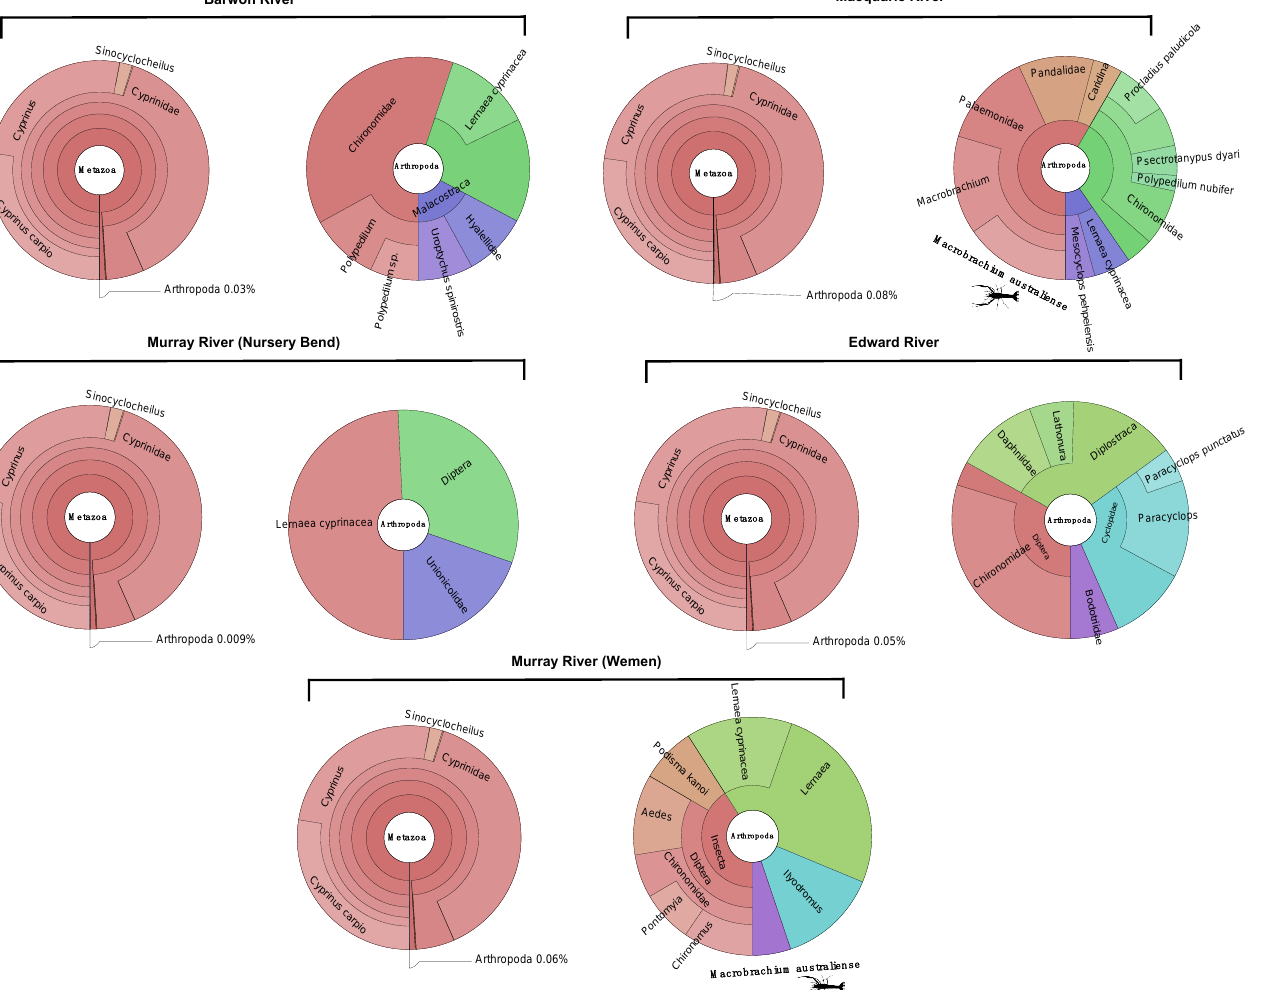
Figure 1. Krona plots showing the relative abundances of C. carpio and arthropod reads in MrNV positive libraries. Each library contains one Krona plot broadly showing the abundance of arthropod compared to fish reads, and another showing the distribution of all arthropod reads. Each library is labelled with its corresponding site.